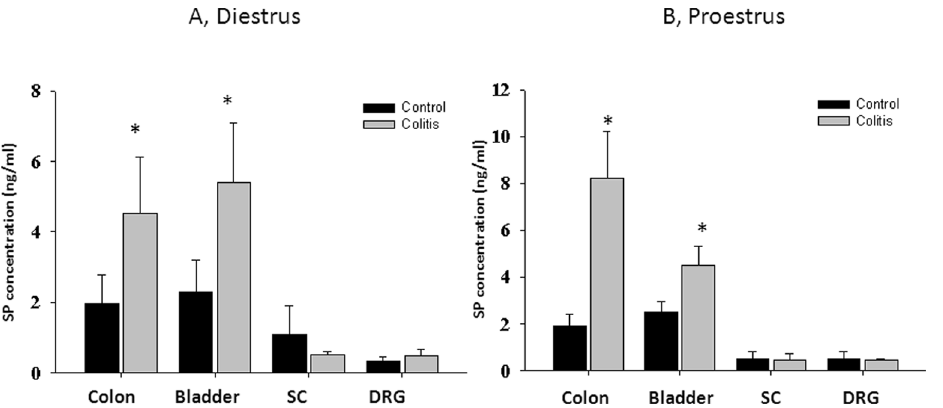
Figure 3. Visceral cross-sensitization up-regulates SP in the pelvic organs. A, Concentration of SP protein in the distal colon, urinary bladder and neural tissues in rats during diestrus. B, Substance P content during proestrus in control and TNBS-treated animals. SC- spinal cord, DRG – dorsal